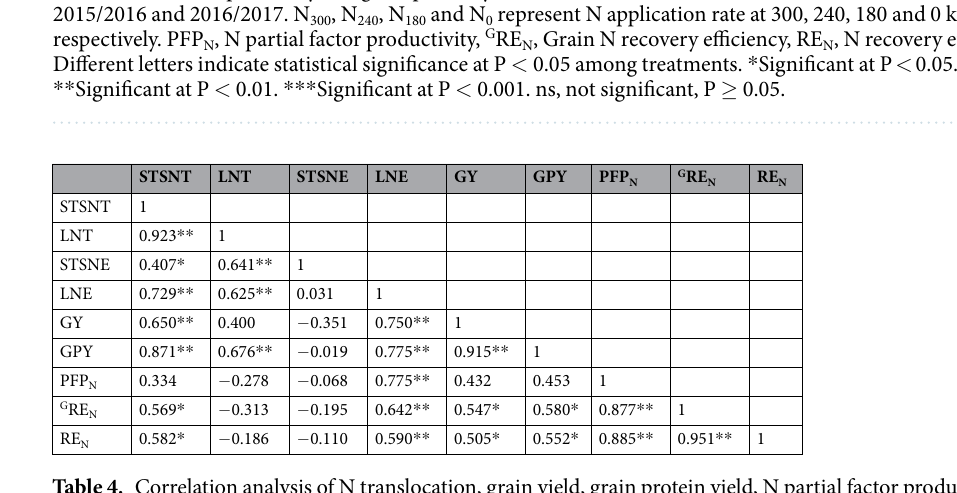
Table 4. Correlation analysis of N translocation, grain yield, grain protein yield, N partial factor productivity (PFP * Correlation is significant at the 0.05 level (2-tailed). ** Correlation is significant at the 0.01 level